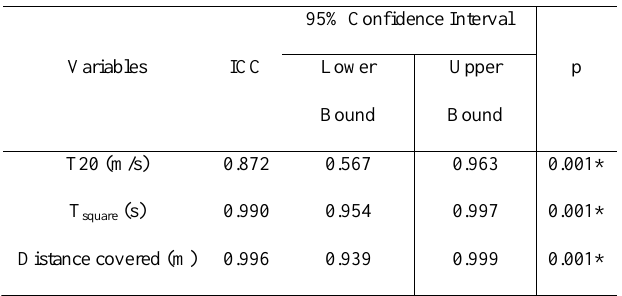
Table 1. Intraclass coeficient correlation for the test-retest (Fami- liarization x Test) in Brazilian amputee soccer